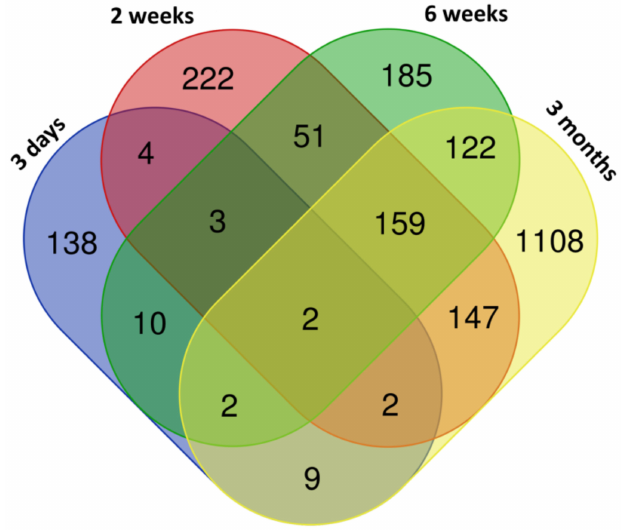
Figure 1. The distribution of common and unique genes di ff erentially expressed after copper(II) oxide nanoparticles (CuO NPs) inhalation.